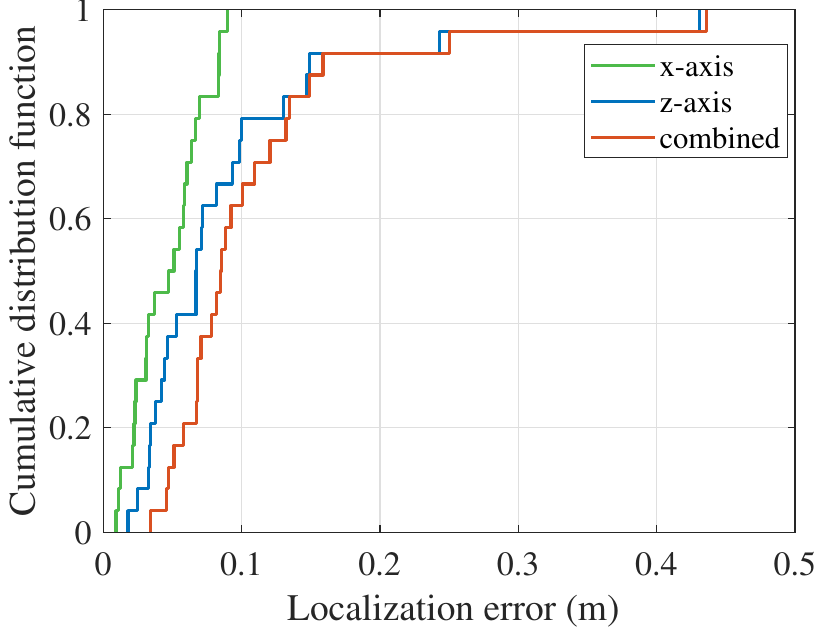
Figure 12. CDF curve of localization error in different